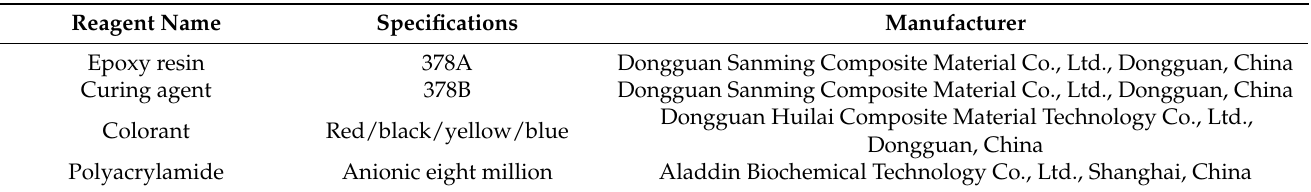
Table 1. The property and source of reagents used in